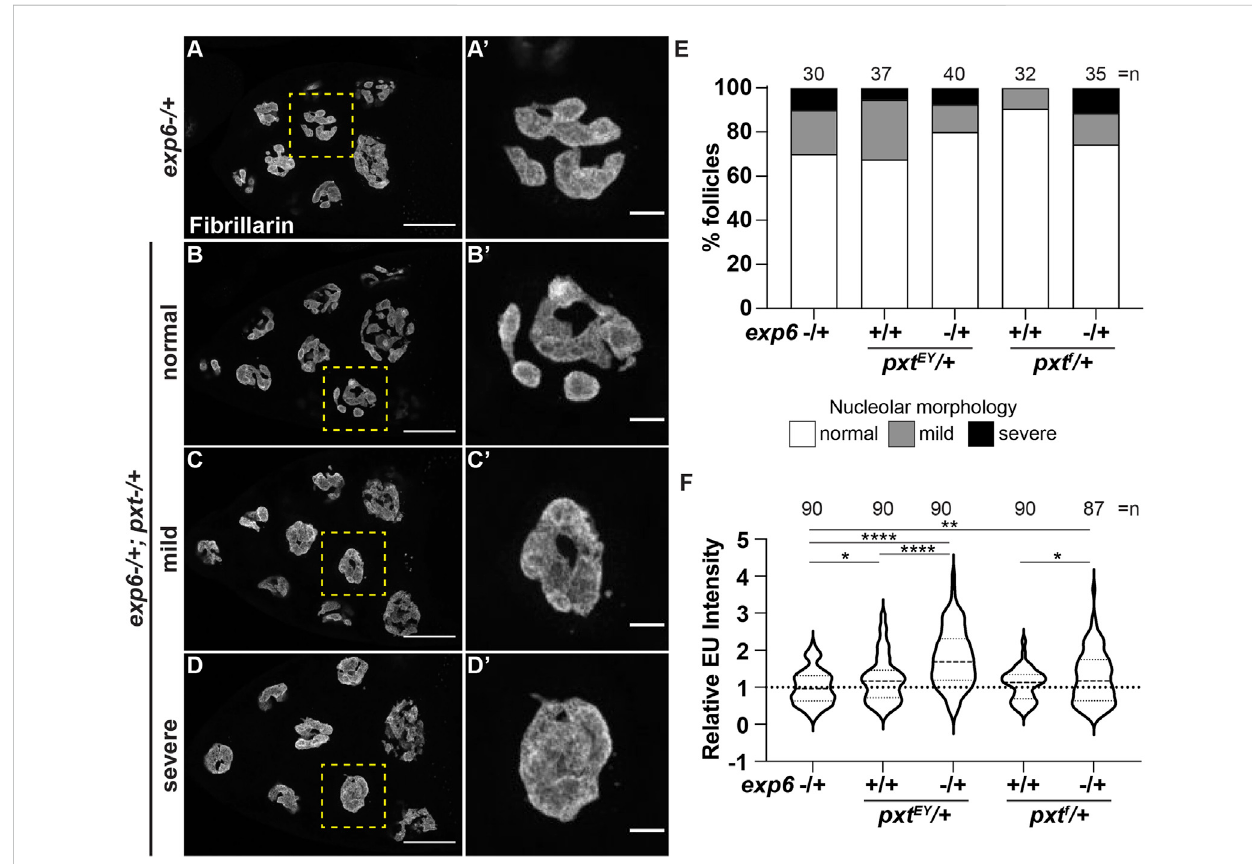
FIGURE 7 Prostaglandinslimitnuclearactintocontrolnucleolaractivity. (A-D ’ ) .Maximumprojectionsof3-4confocalslicesof exp6 − /+ (control)and exp6 − /+; pxt EY /+ S10B follicles (A – D) , scale bars = 50 μ m, or zoomed in images of single nurse cells boxed in yellow (A 9 -D 9 ) , scale bars = 10 μ m, stained for the nucleolus (Fibrillarin). Examples of the varying nucleolar morphologies observed in the double heterozygotes are shown, normal vs. mild or severe defects. (E) . Graph quantifying thepercentage offollicles exhibiting normal (white) vs. mild (gray) or severe (black) defects in nucleolar morphology; n = number of follicles. (F) . Graph quantifying the relative EU fl uorescence intensity of the indicated genotypes, **** p < 0.0001, ** p < 0.01, * p < 0.05 (unpaired t-test). n = number of follicles. Heterozygosity for exp6 has little effect on nucleolar structure (A-A 9 ) , whereas follicles from double heterozygotes of exp6 and pxt exhibit varying nucleolar morphologies, from normal to severe defects (B-D 9 ) ; quanti fi cation of the level of defects indicates these changes are not statistically signi fi cant (E) . In contrast, double heterozygotes of exp6 and pxt exhibit increased nascentnucleolar RNA (F)